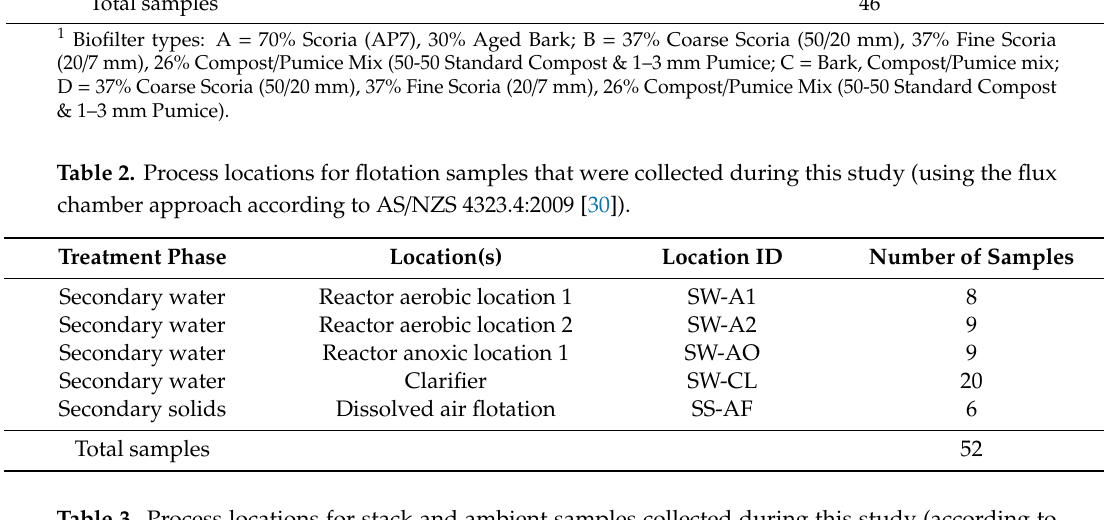
Table 3. Process locations for stack and ambient samples collected during this study (according to AS / NZS 4323.3:2001